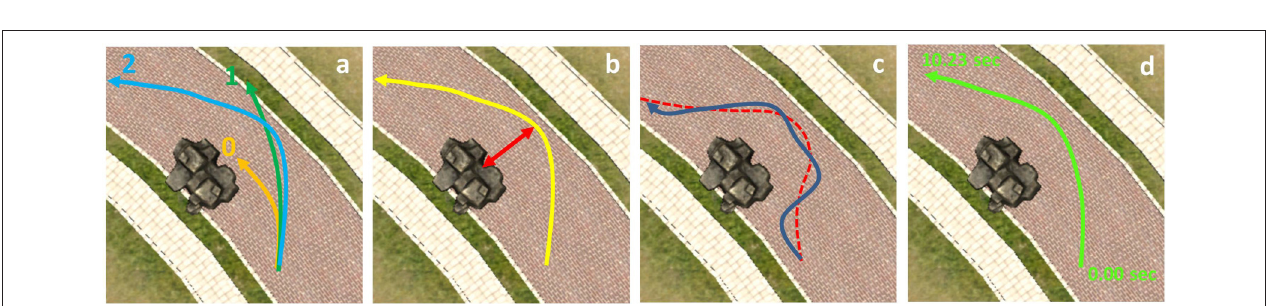
Frontiers in Neurorobotics |